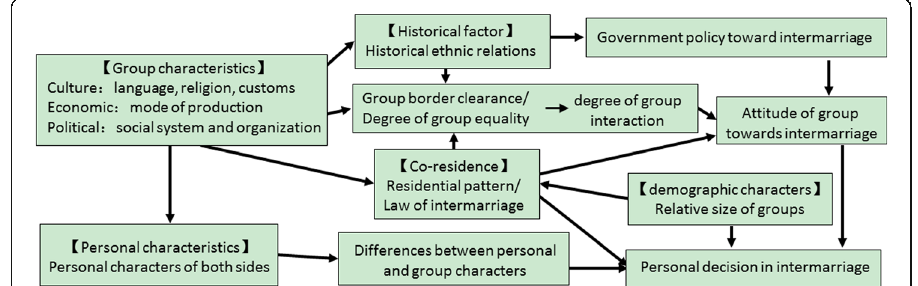
Fig. 1 Factors affecting personal preference in intermarriages. Source: Ma Rong